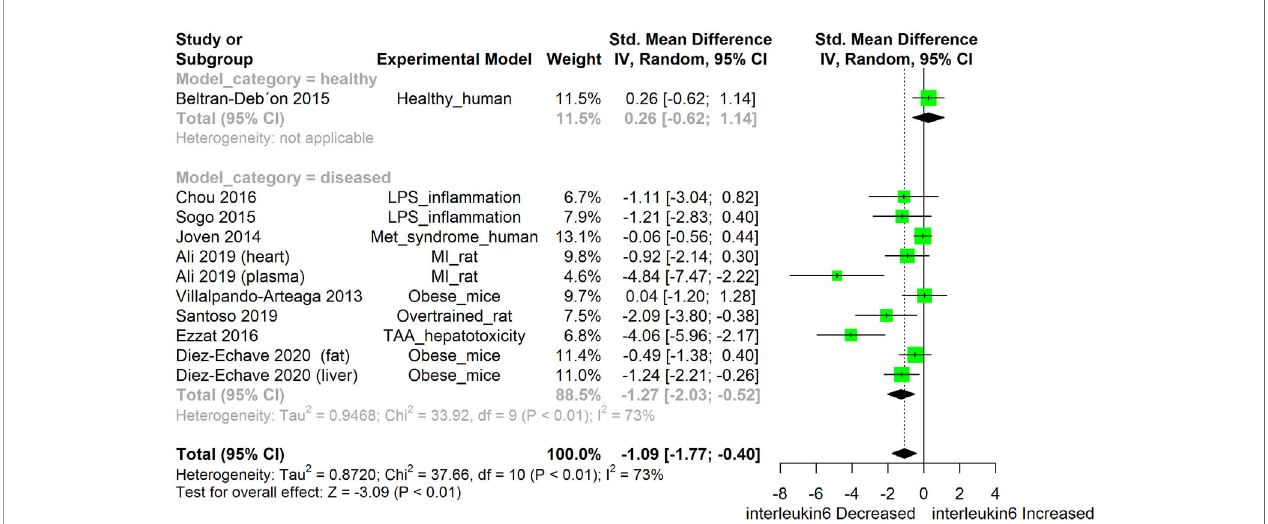
Table 2 . HS calyx extract elicited signi fi cant anti-in fl ammatory